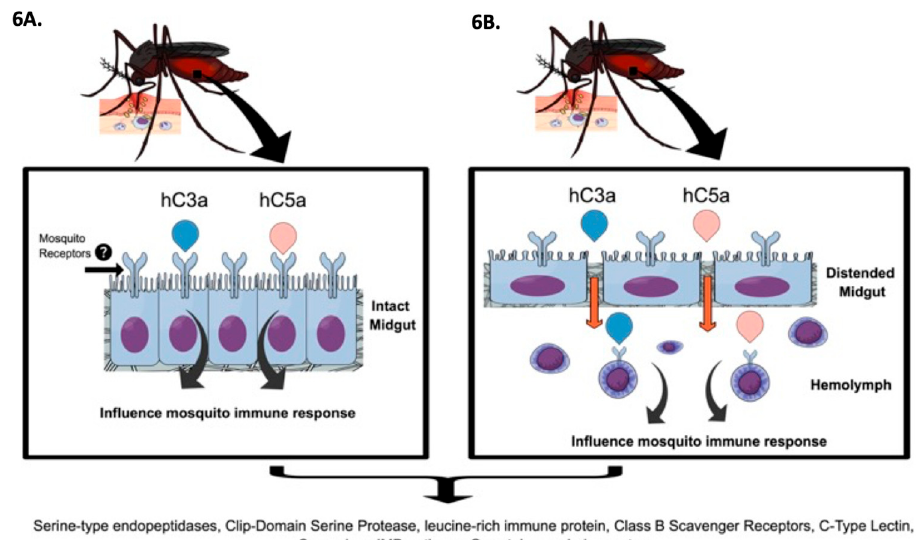
Figure 6. Graphical summary of our hypothesized mechanism of action of the effect of human complement proteins on mosquito cell transcripts. ( A ) Human complement proteins may interact with mosquito cells in the midgut; ( B ) Distention produced by the ingestion of blood may allow for the scape of complement molecules into the hemocoel where they could potentially interact with hemocytes.